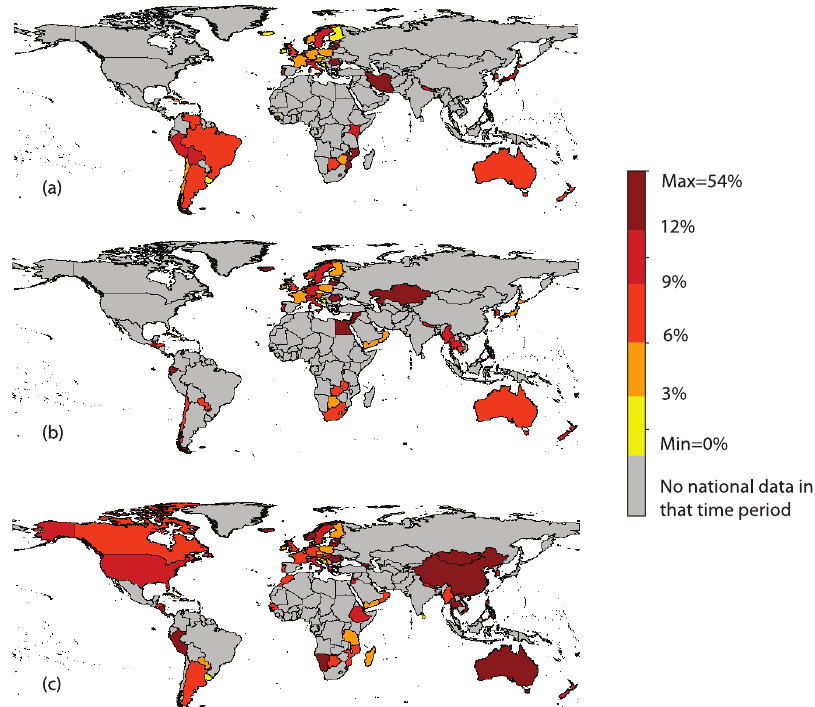
Figure 1. Percentage of incident TB cases with isoniazid resistance. World map showing the percentage of incident TB cases with isoniazid resistance (INH-R) from the most recent survey in each setting in three time periods: (a) 1994-1999, (b) 2000-2004, (c) 2005-2009. Grey areas indicate those that did not report national data in the time period in question.